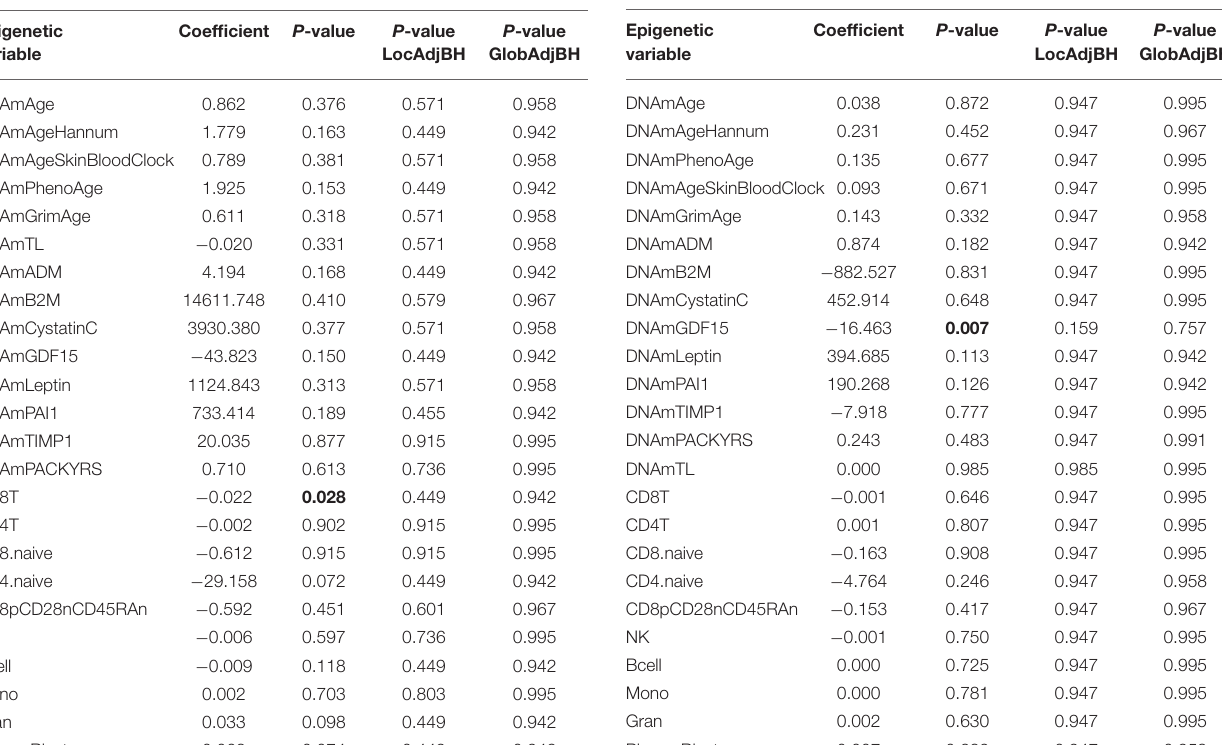
TABLE 2 | Results of statistical hypothesis testing comparing discordant MZ twins with high and low heat pain sensitivity, using the MLR approach correcting for chronological age, and including family as a random effect.